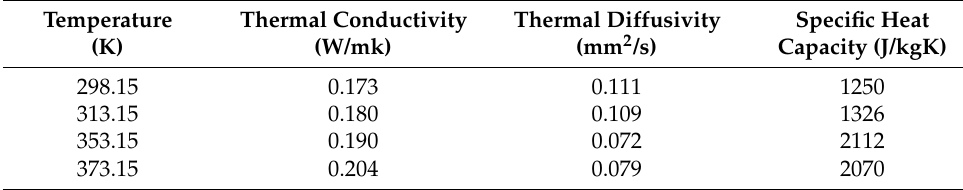
Table 3. Thermophysical properties of pure PLA 1 .